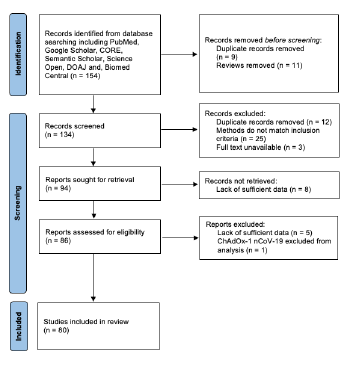
Figure 1. Preferred Reporting Items for Systematic Reviews and Meta-Analyses (PRISMA) statement demon- strating the different phases of study selection of the systematic